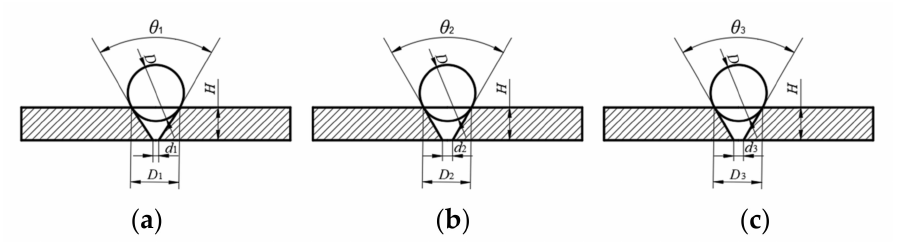
Figure 3. The sucking hole structural diagram. ( a ) Sucking hole of the inner ring; ( b ) Sucking hole of the middle ring; ( c ) Sucking hole of the outer ring.